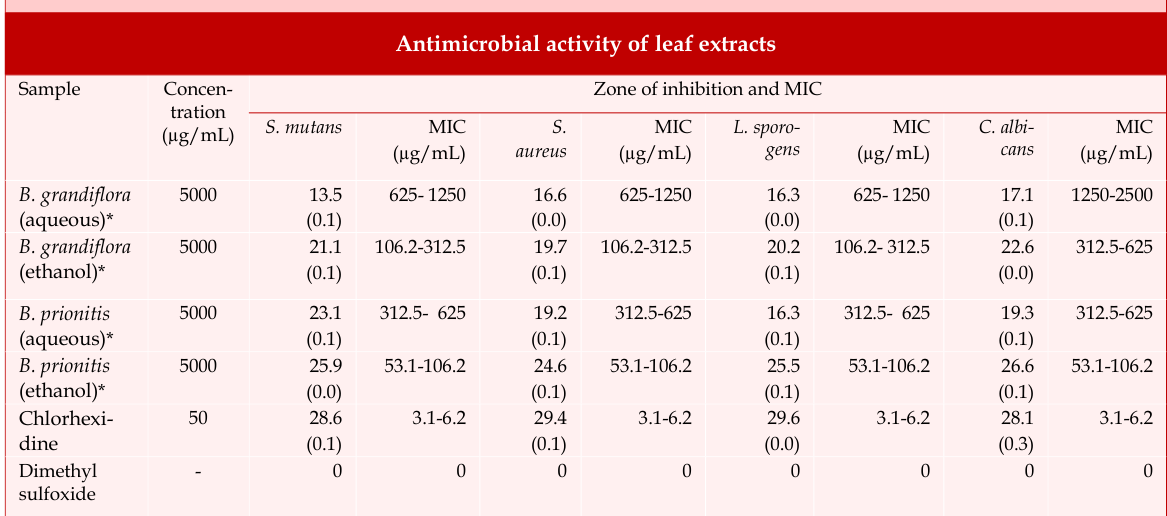
was statistically significant (p<0.05) in comparison to